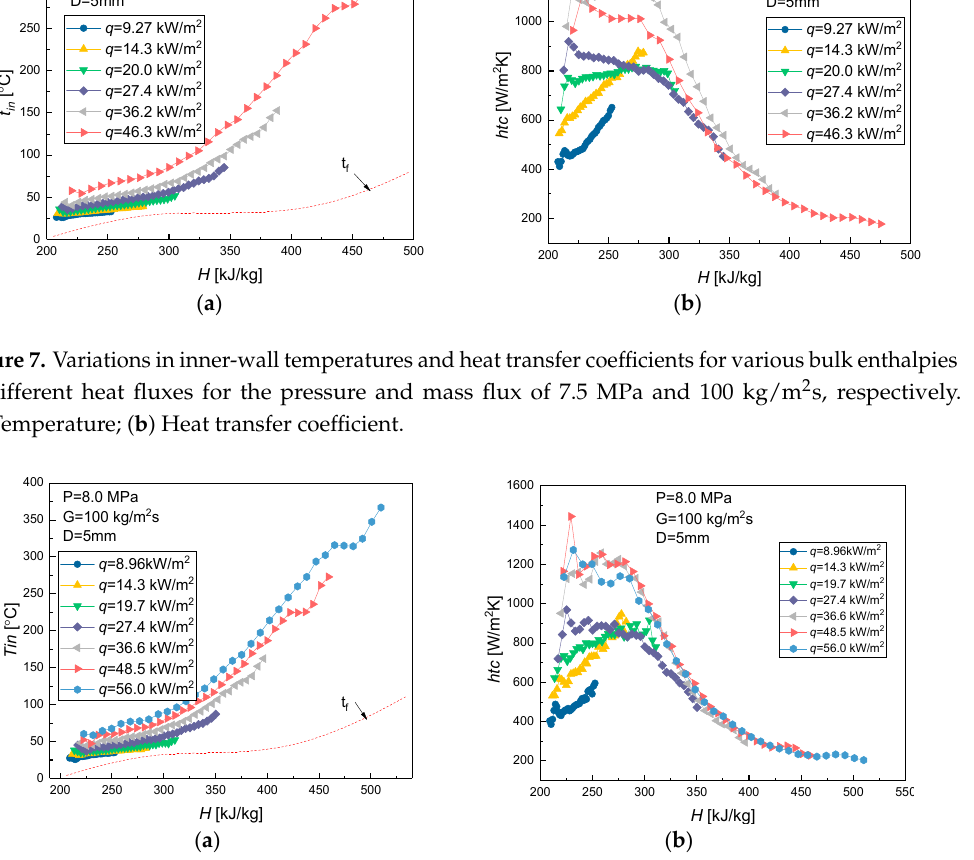
Figure 8. Variations in inner-wall temperatures and heat transfer coefficients for various bulk enthalpies at different heat fluxes for the pressure and mass flux of 8.0 MPa and 100 kg/m 2 s, respectively. ( a ) Temperature; ( b ) Heat transfer coefficient.